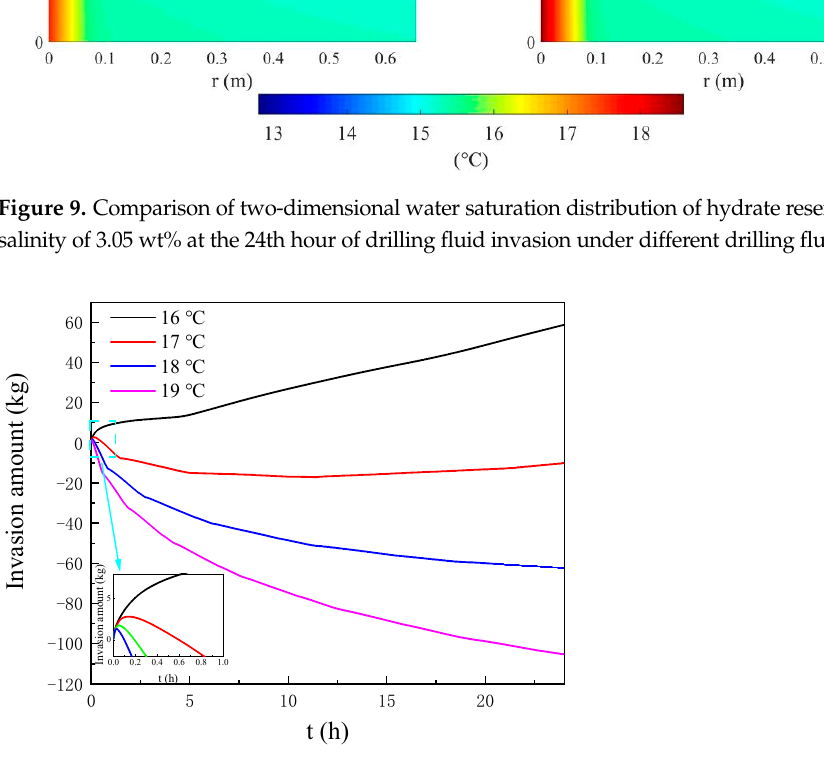
Figure 10. Variation in drilling fluid invasion amount with time within 24 h during the drilling fluid invasion process under different drilling fluid temperatures.